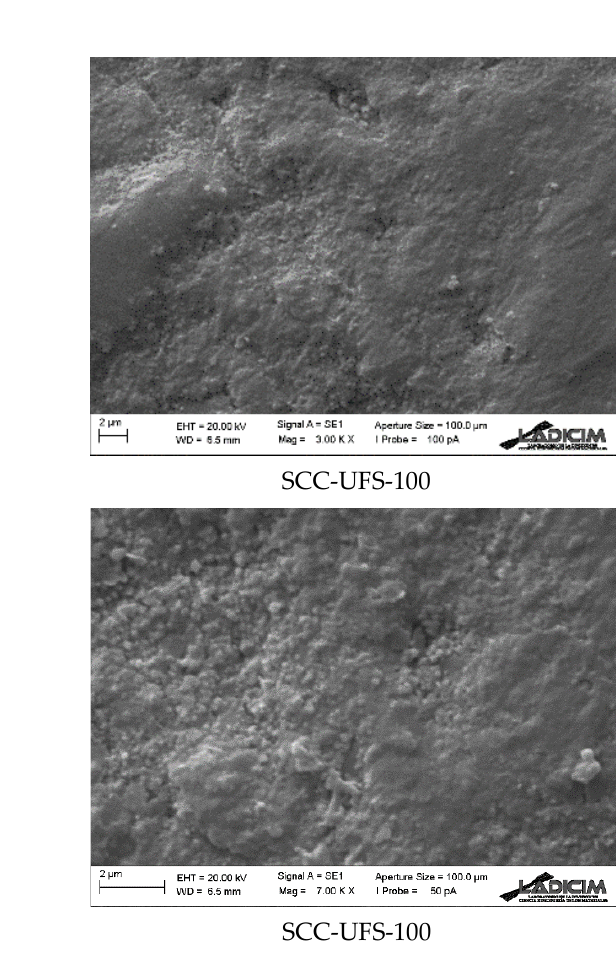
Figure 9. Micrographs obtained at 3000× and 7000×.